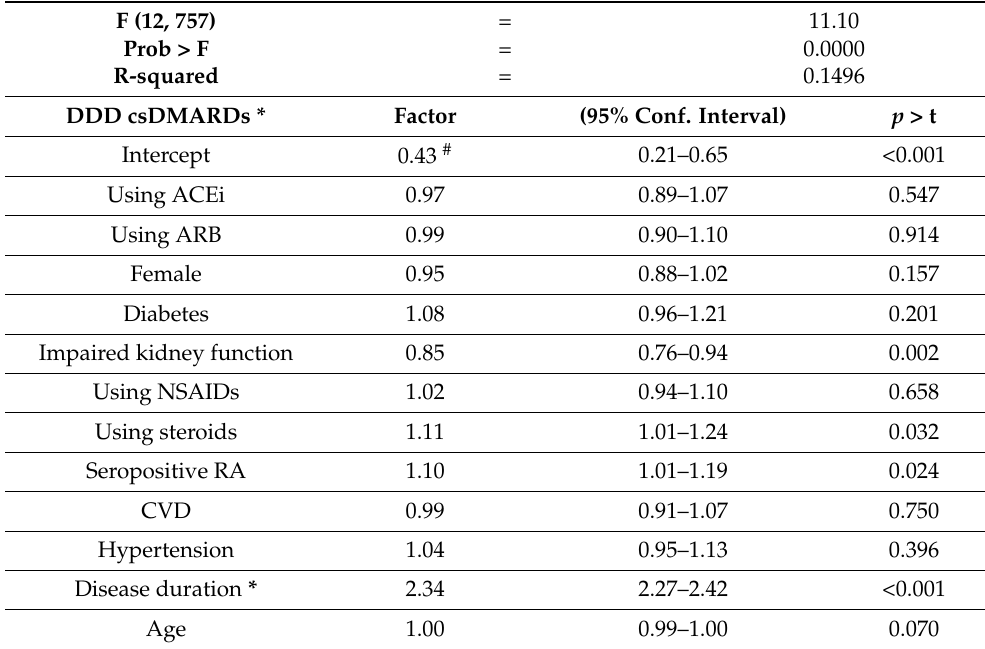
Table 3. Multiple linear regression of multiple confounders on the defined daily dose of